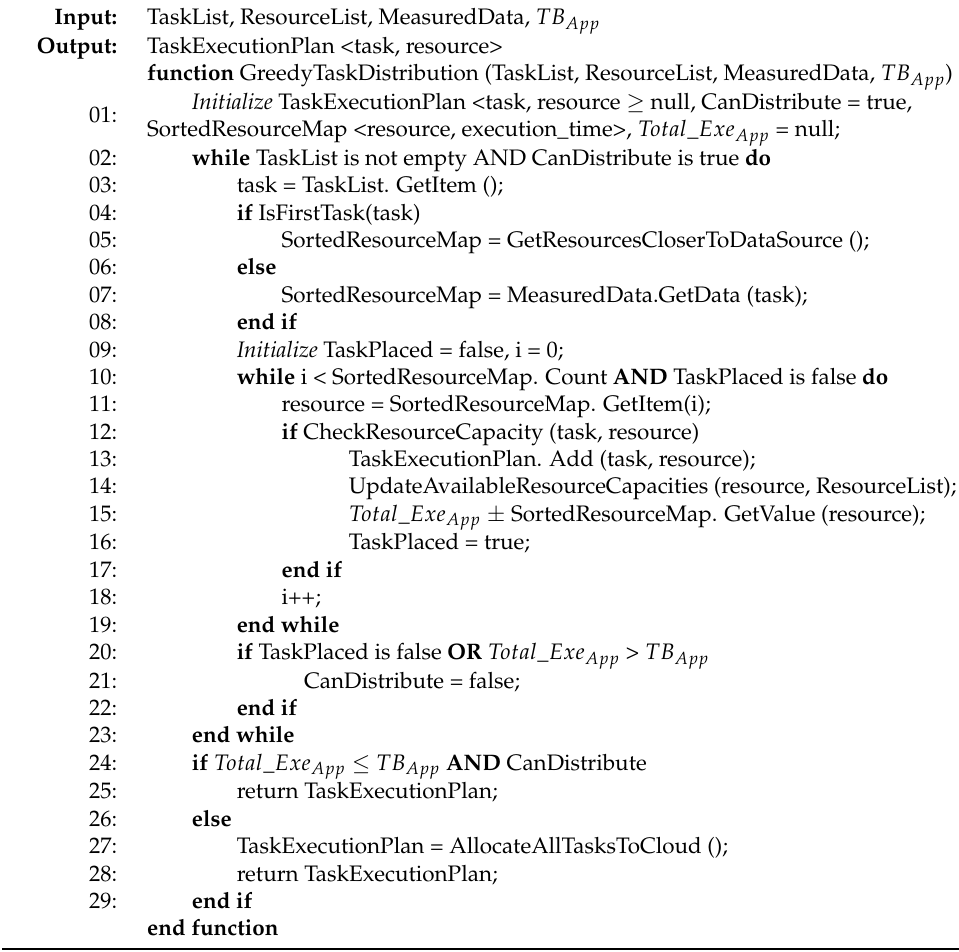
Algorithm 2: Greedy Task Distribution